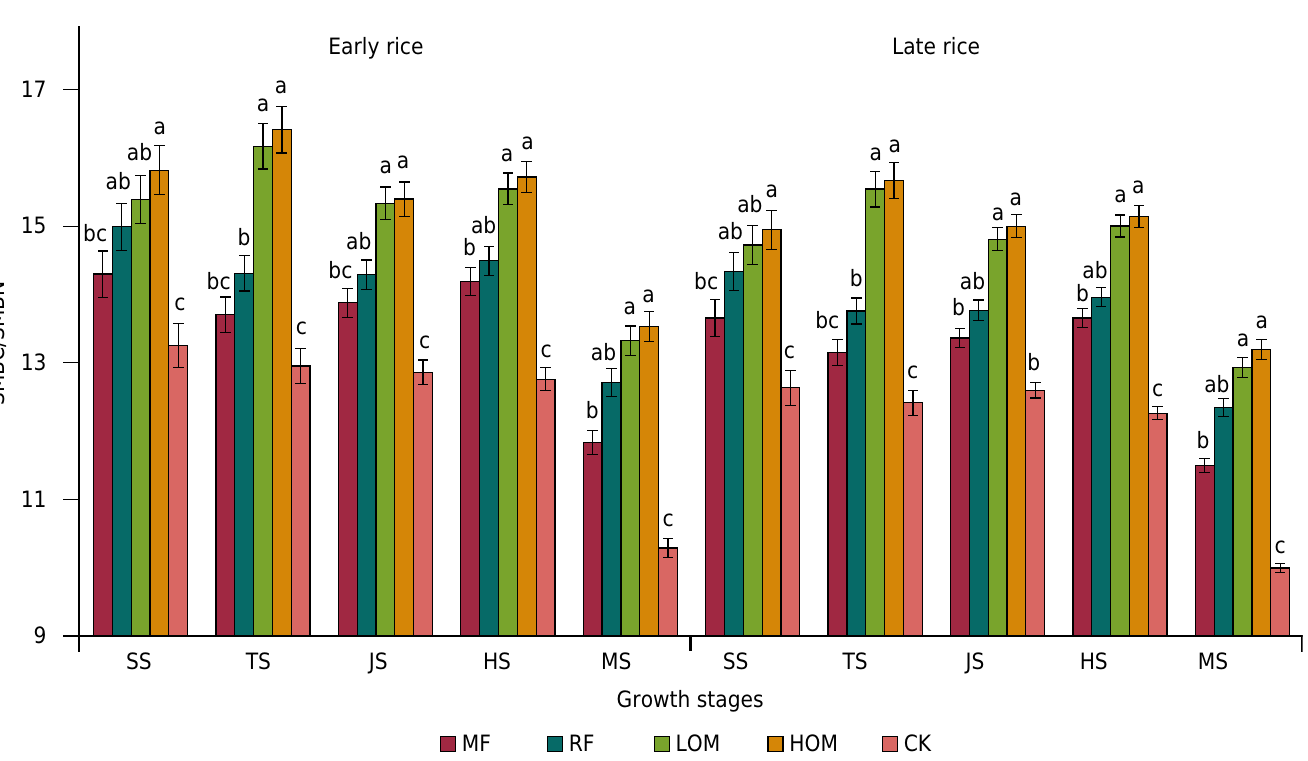
Figure 4. Effects of different long-term fertilization treatments on soil microbial biomass carbon and nitrogen ratio in a paddy field at main rice growth stages. MF = mineral fertilizer alone; RF = rice straw residues and mineral fertilizer; LOM = 30 % organic matter and 70 % mineral fertilizer; HOM = 60 % organic matter and 40 % mineral fertilizer; CK = without fertilizer input; SS = seedling stage; TS = tillering stage; JS = jointing stage; HS = heading stage; MS = mature stage. Bars represent standard deviation (SD) of three replicates. Different letters indicate significance at p < 0.05 among the fertilization treatments at the same rice growth stage, according to the least significant difference test.